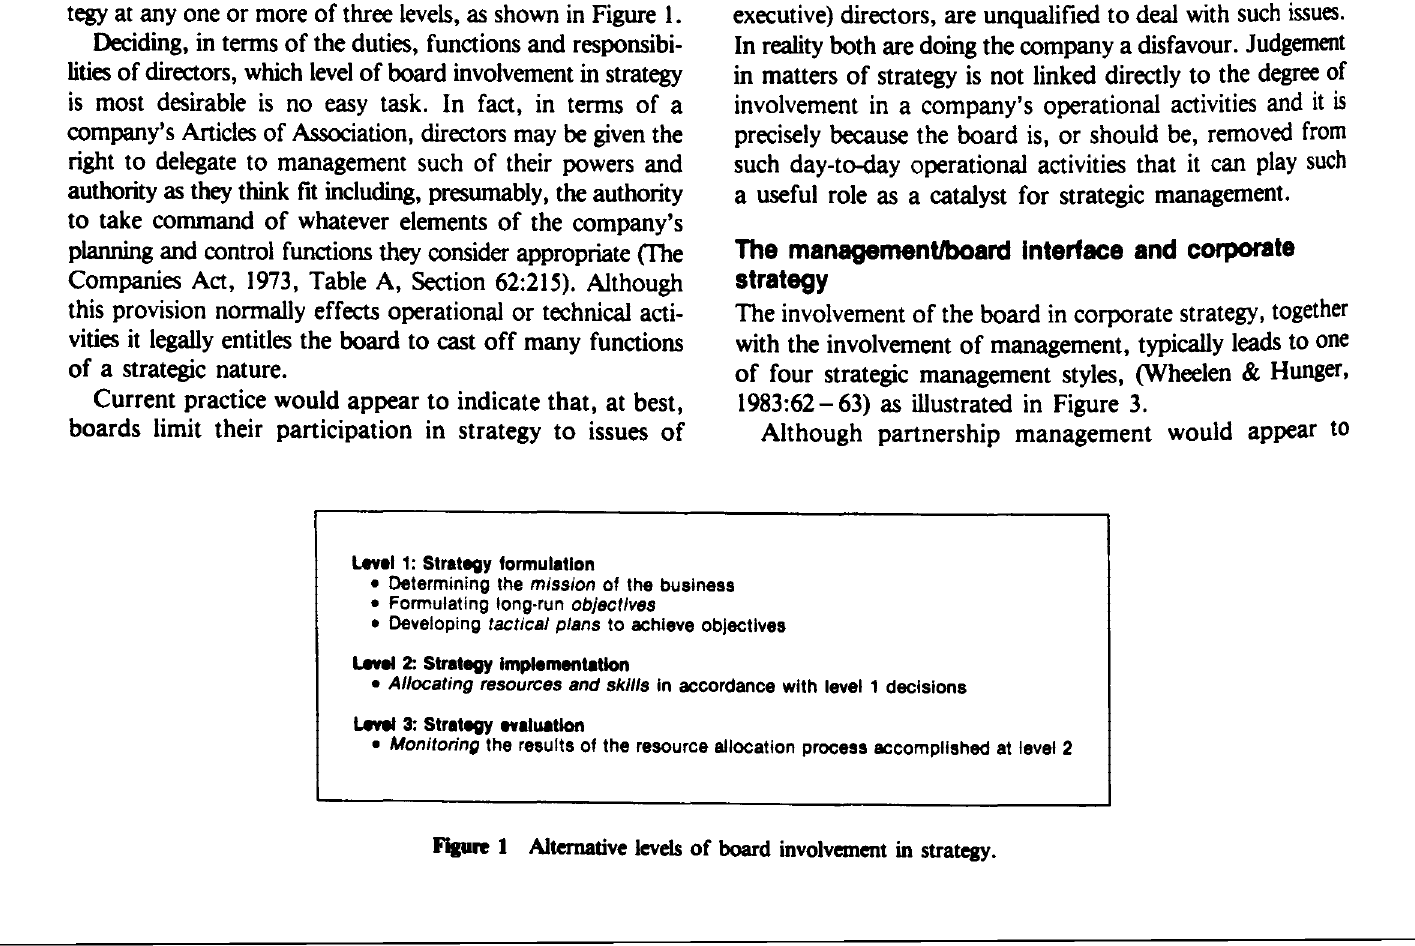
Figure 1 Alternative levels of board involvement in